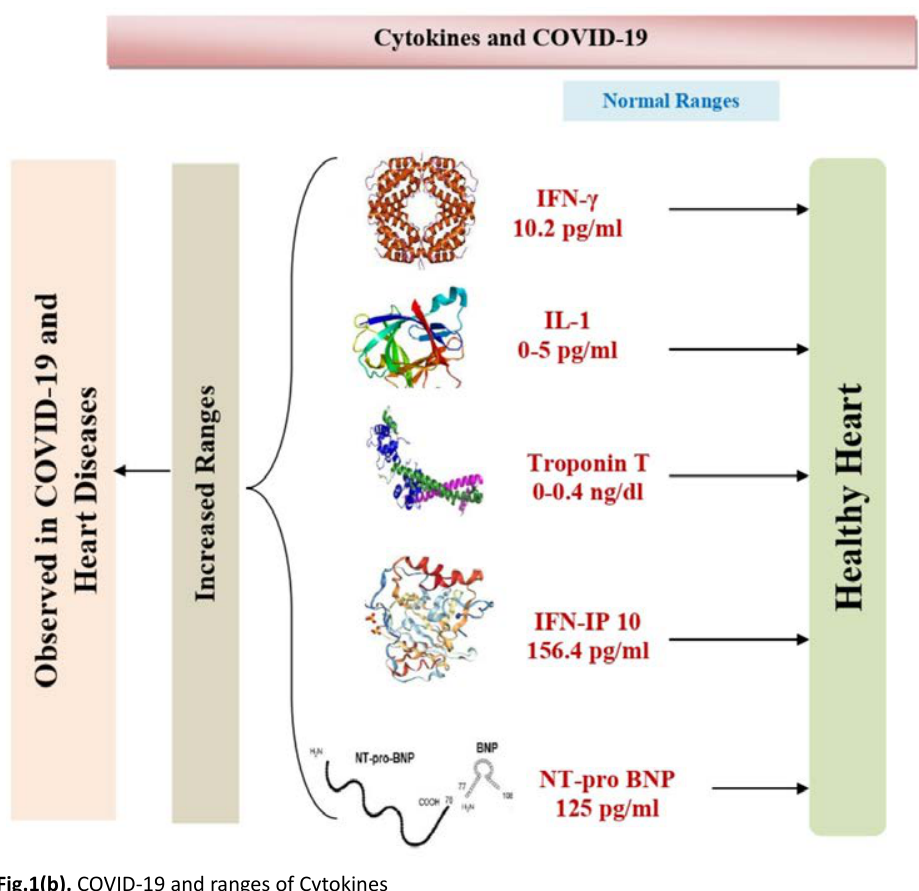
Fig.1(b). COVID-19 and ranges of